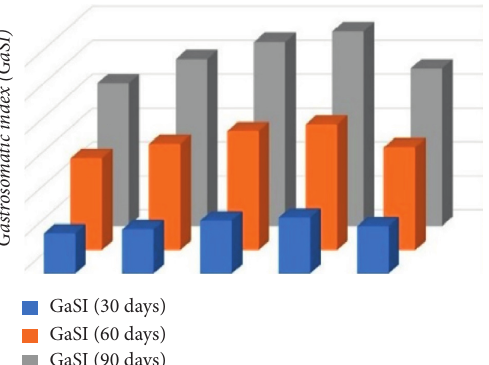
Figure 8: Cyprinus carpio fed varied doses of Aloe vera and Gastrosomatic index (GaSI) level studied after 90 days of feeding